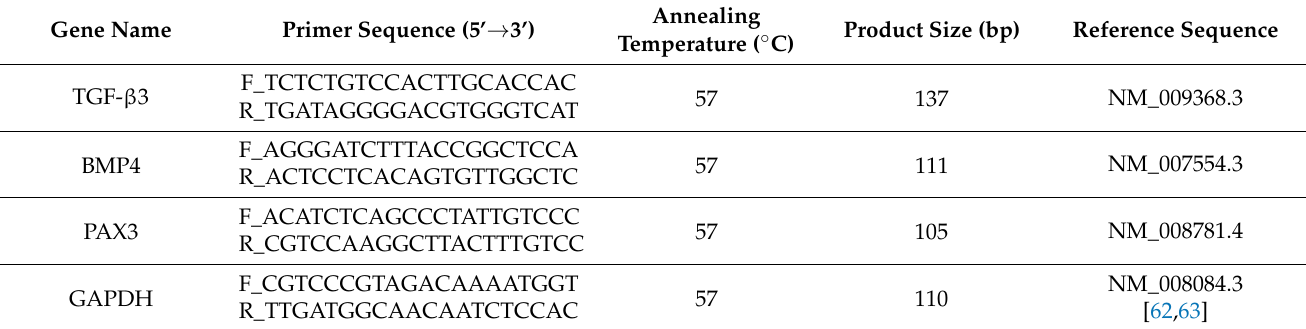
Table 5. Primer sequences for real-time